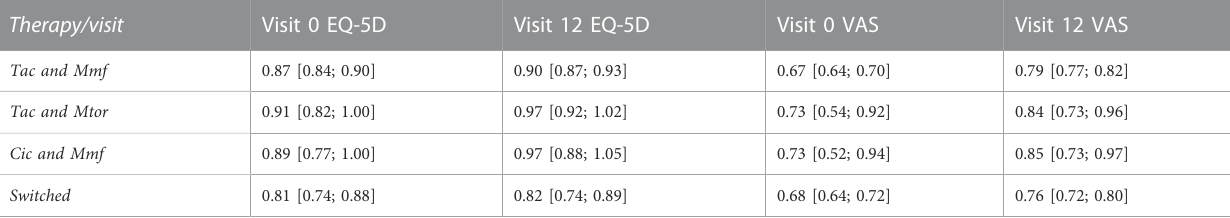
TABLE A1 95% Con fi dence intervals corresponding to the Figure 2 data